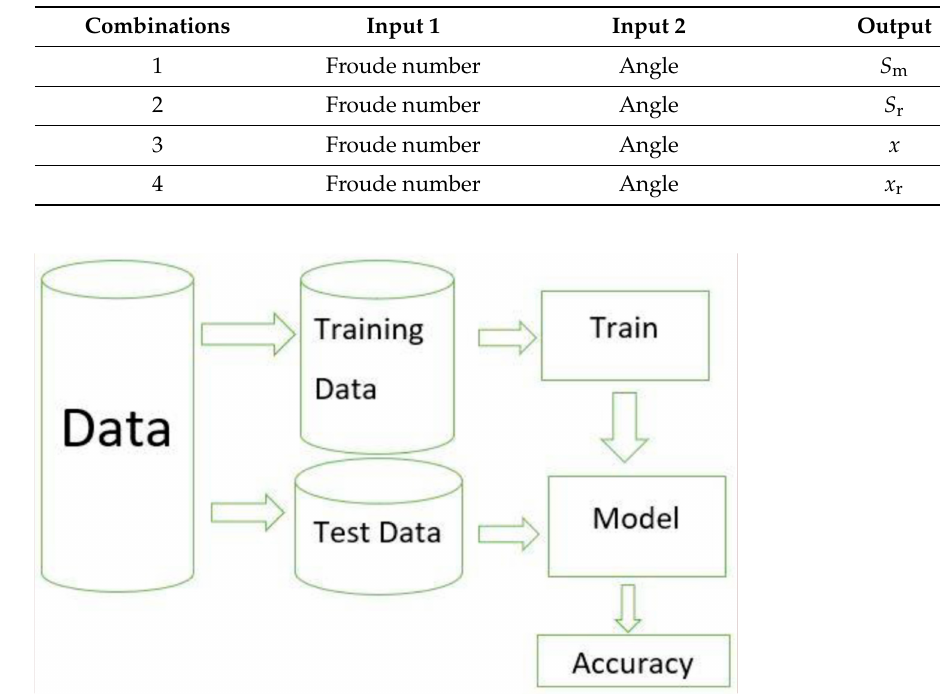
Table 1. Input-Output combinations.